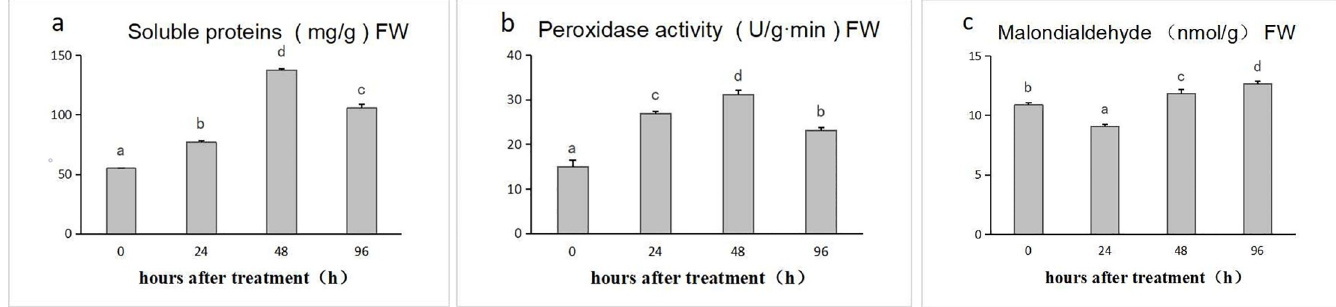
Fig 1. Physiological and biochemical changes in Larix olgensis under drought stress. (a) Effect of drought stress on soluble protein (SP) content. (b) Effect of drought stress on peroxidase (POD) activity. (c) Effect of drought stress on malondialdehyde (MDA) content. Error bars represent standard error.